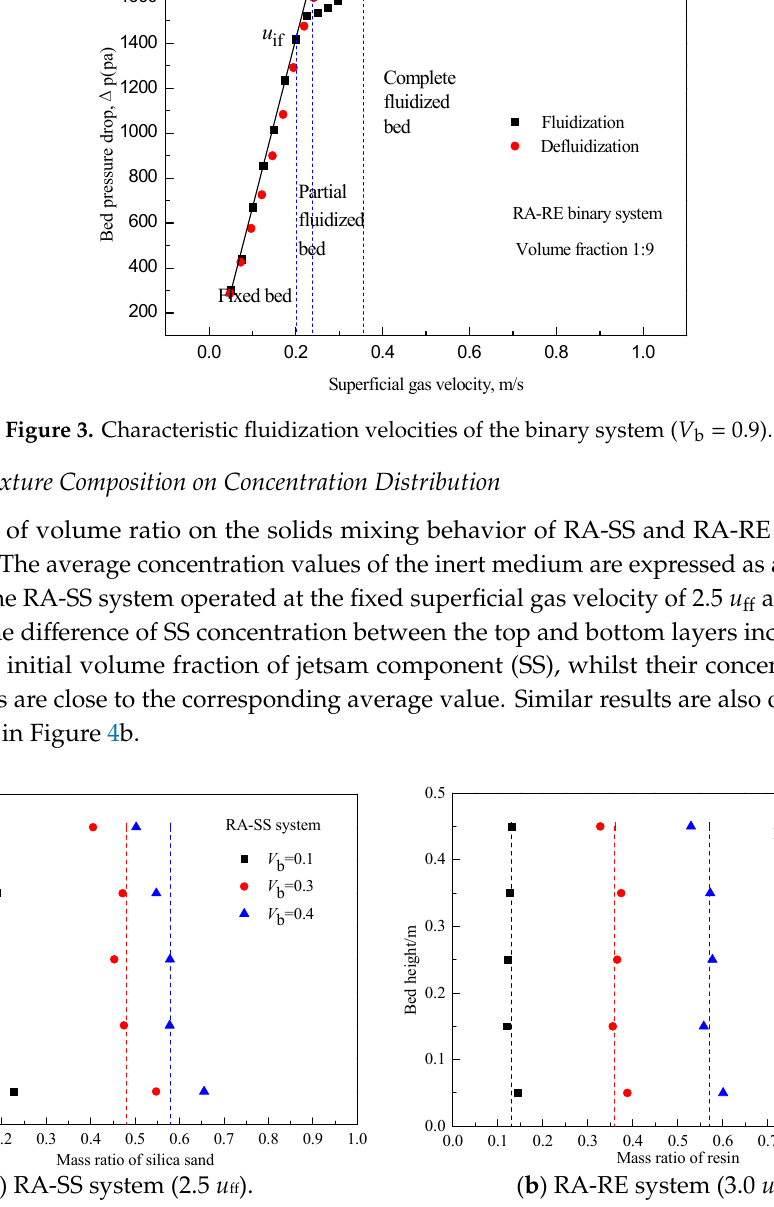
Figure 4. Effect of volume fraction on concentration profiles.